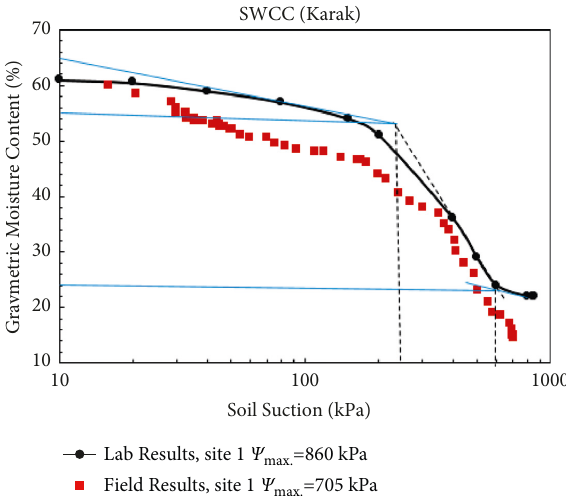
Figure 6: Demonstration of field- and lab-based SWCCs for Karak expansive soil.